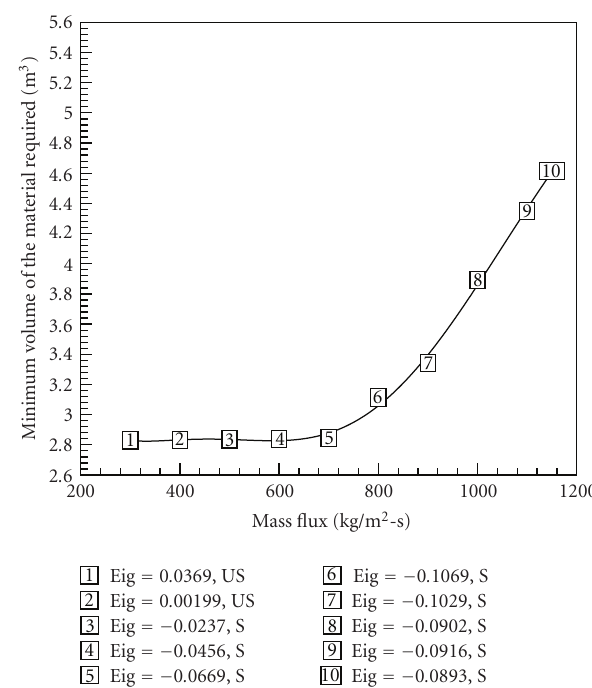
Figure 15: Variation of minimum volume of the material required with mass flux.